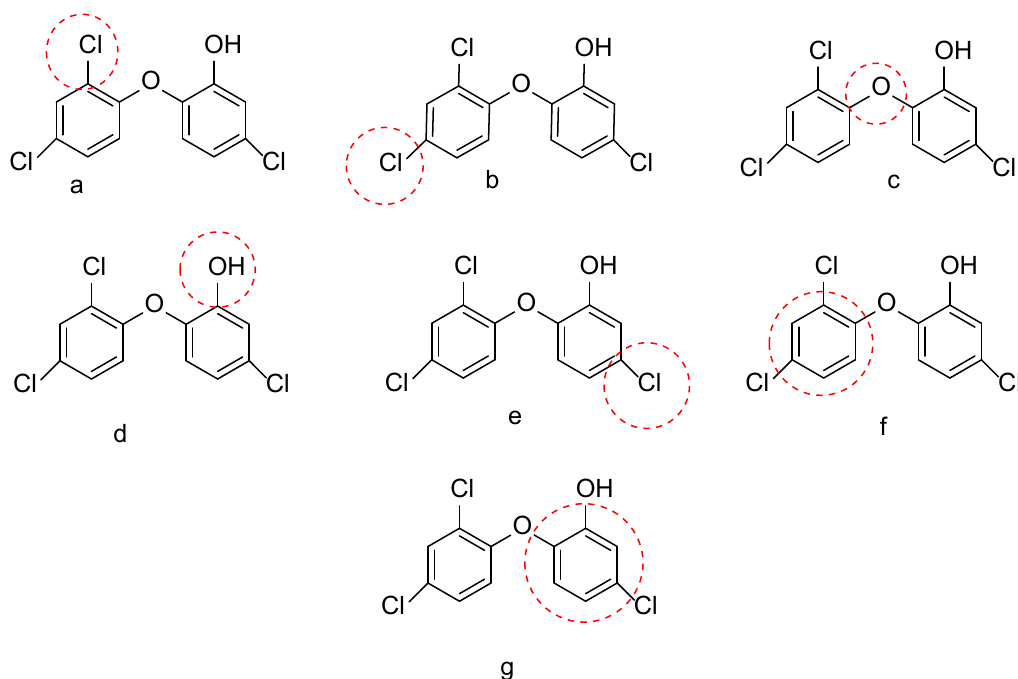
Fig. 2. Different active places in triclosan